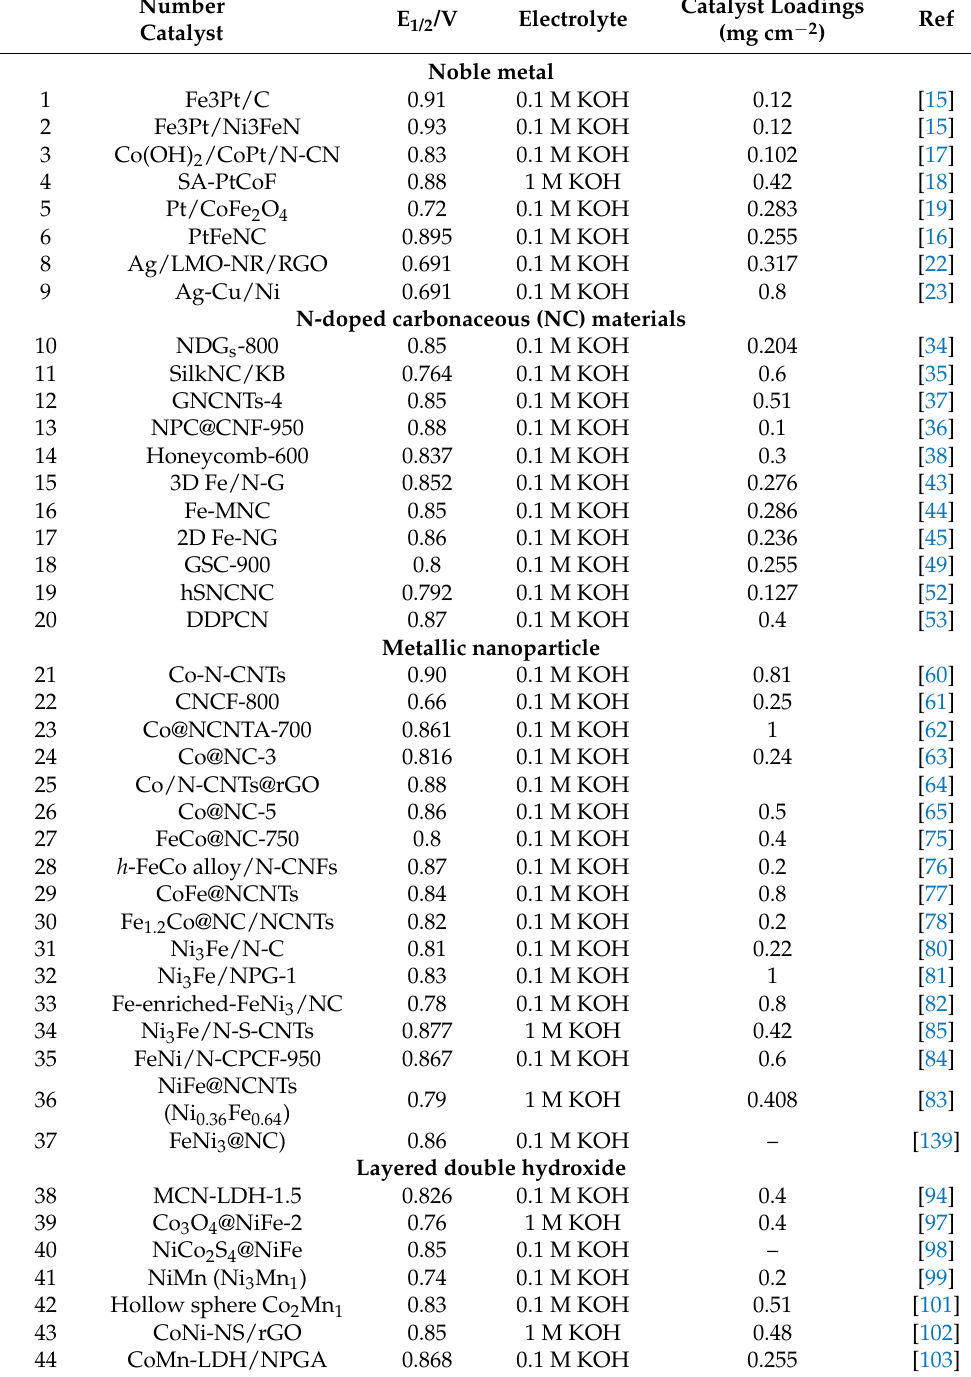
Table 2. ORR performance of catalysts based on noble metals, N-doped carbonaceous materials, metallic nanoparticles, metal chalcogenides, layered double hydroxides, and metal